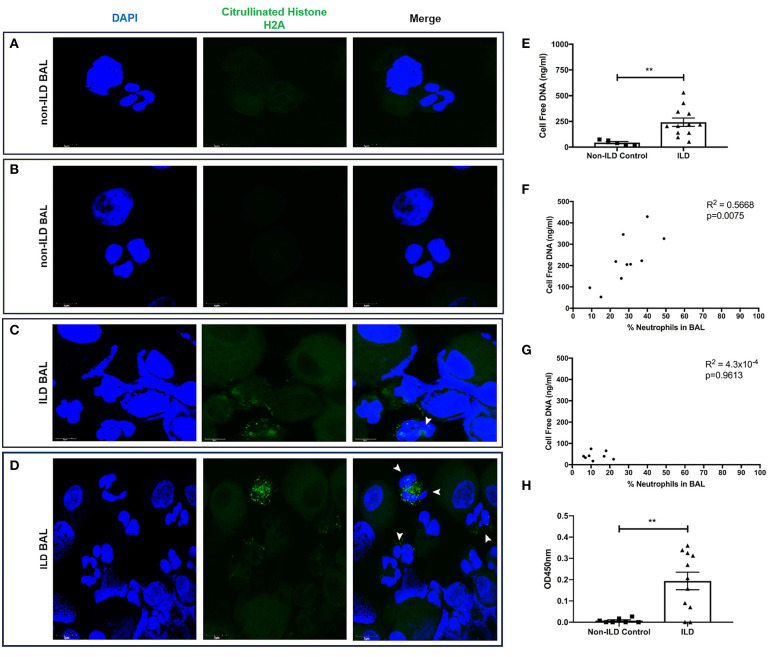
BAL isolated from ILD patients contain more NETs and NET-releasing neutrophils. BAL from ILD patients and non-ILD controls was examined for evidence of neutrophil activation. We first performed confocal microscopy to identify NETs as defined by nuclear DNA (DAPI, blue staining) and citrullinated histone expression (citrullinated histone H2A, green staining). (A,B) Non-ILD control BAL cells displayed punctate nuclear staining and lack of citrullinated histones, whilst (C,D) BAL cells obtained from patients with ILD showed degrees of DNA externalization from polymorphonuclear cells, along with the presence of citrullinated histones indicative of neutrophils undergoing NET release (white arrowheads). Representative images from two non-ILD or ILD donors are shown and the size is denoted by the scale bar. (E) BAL fluid was then assessed for the presence of NETs by Quant-iT™ PicoGreen® dsDNA assay (Thermo Fisher, UK), which found that BAL fluid from ILD patients (n = 11) has significantly more cell free DNA compared to non-ILD controls (n = 8). From differential cell counts, we found that (F) cell free DNA positively correlated with the proportion of BAL neutrophils in patients with ILD, (G) but not in non-ILD controls. (H) Finally, we also tested BAL fluid using an optimized capture ELISA detecting MPO-citrullianted histone H3 complexes, demonstrating that BAL fluid from ILD patients (n = 11) has significantly more NETs compared to non-ILD controls (n = 8). Data were analyzed by either a Mann-Whitney test or two-tailed Pearson correlation coefficients. ** = p < 0.01. BAL, bronchoalveolar lavage; ILD, interstitial lung disease.